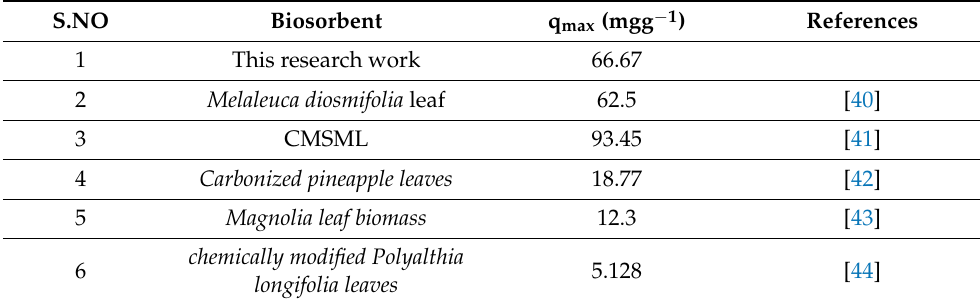
Table 5. Biosorption capacity comparison of CMPVL with the literature.